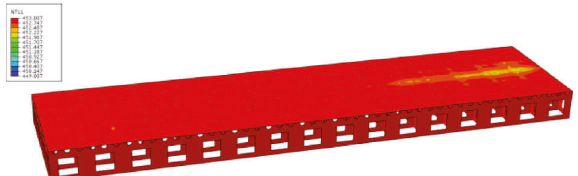
Figure 6: Temperature nephogram of the tool at the end of the heat preservation.